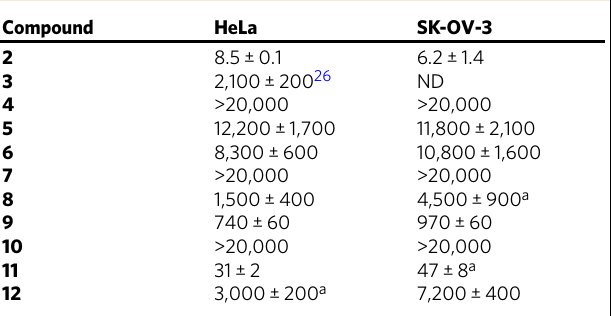
a data from 4 independent experiments. GI 50 values were obtained from three independent experiments (unless otherwise noted) each performed in triplicate and presented as mean±SEM. Source data are provided as a Source Data fi